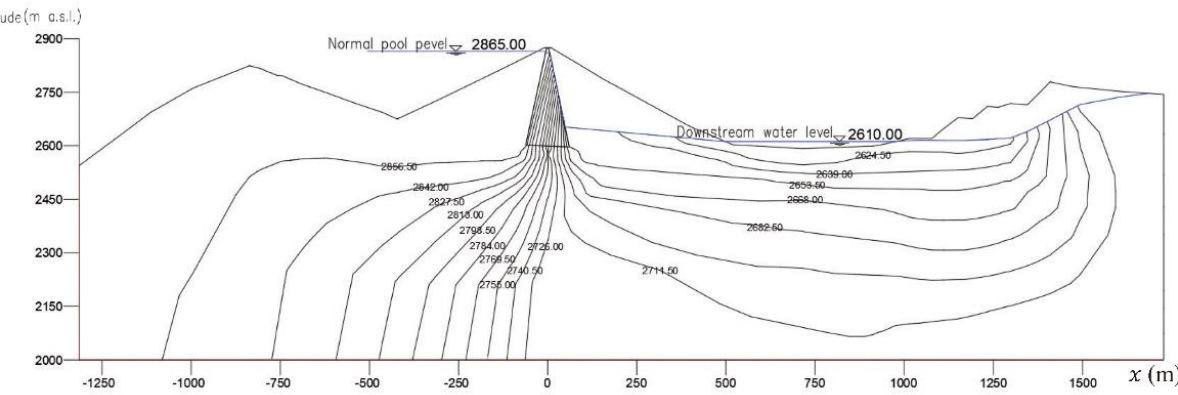
Figure 22. Piezometric contours and water table in the dam body (y = 600 m).